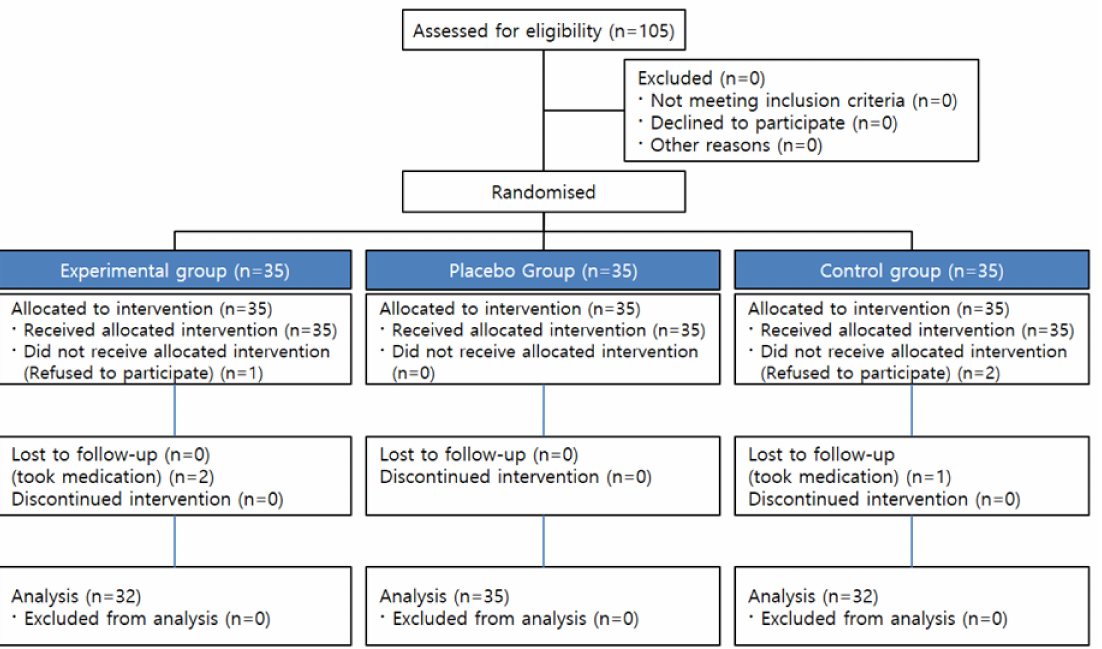
Figure 2. Process flow